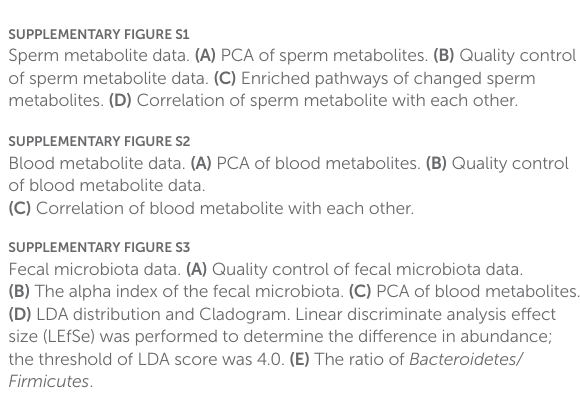
SUPPLEMENTARY FIGURE S1 Sperm metabolite data. (A) PCA of sperm metabolites. (B) Quality control of sperm metabolite data. (C) Enriched pathways of changed sperm metabolites. (D) Correlation of sperm metabolite with each other. SUPPLEMENTARY FIGURE S2 Blood metabolite data. (A) PCA of blood metabolites. (B) Quality control of blood metabolite data. (C) Correlation of blood metabolite with each other. SUPPLEMENTARY FIGURE S3 Fecal microbiota data. (A) Quality control of fecal microbiota data. (B) The alpha index of the fecal microbiota. (C) PCA of blood metabolites. (D) LDA distribution and Cladogram. Linear discriminate analysis